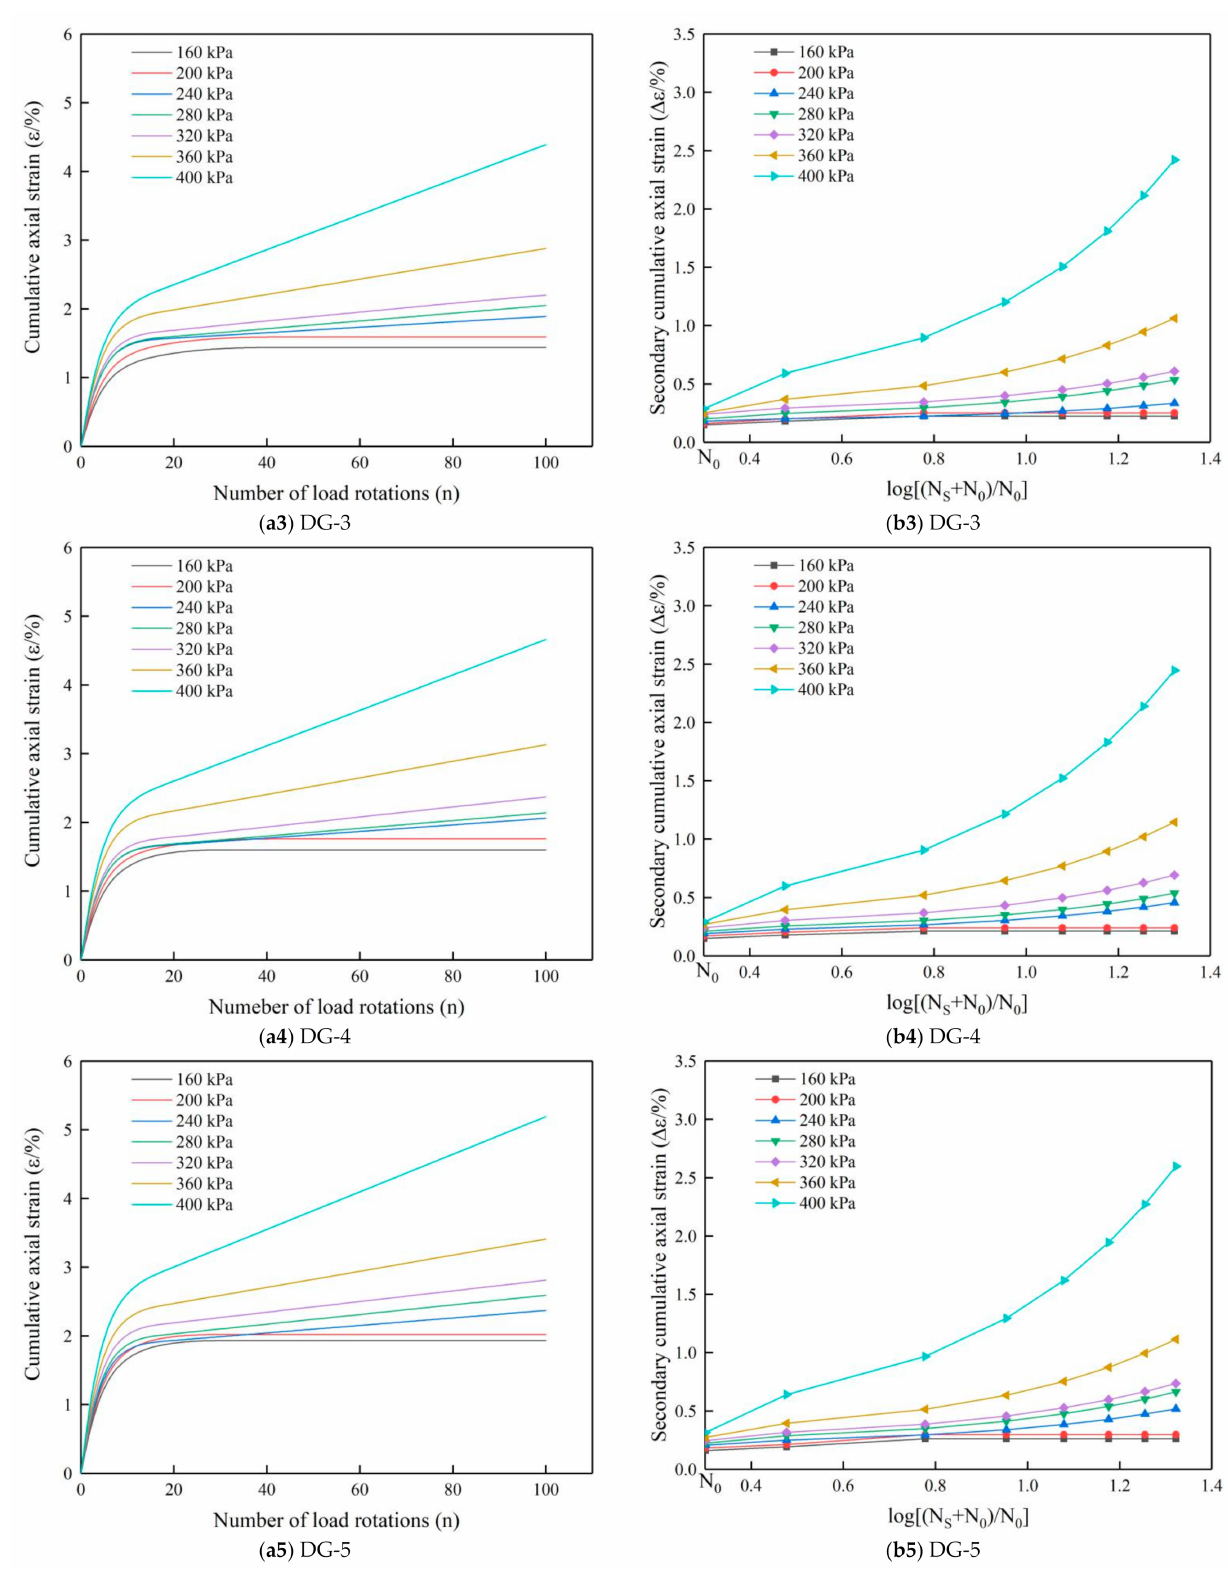
Figure 10. ( a1 – a5 ) Cumulative axial strain of large-size graded crushed stone of five gradation types under different loads; ( b1 – b5 ) secondary cumulative axial strain versus log[( N S + N 0 )/ N 0 ] of large-size graded crushed stone of five gradation types under different